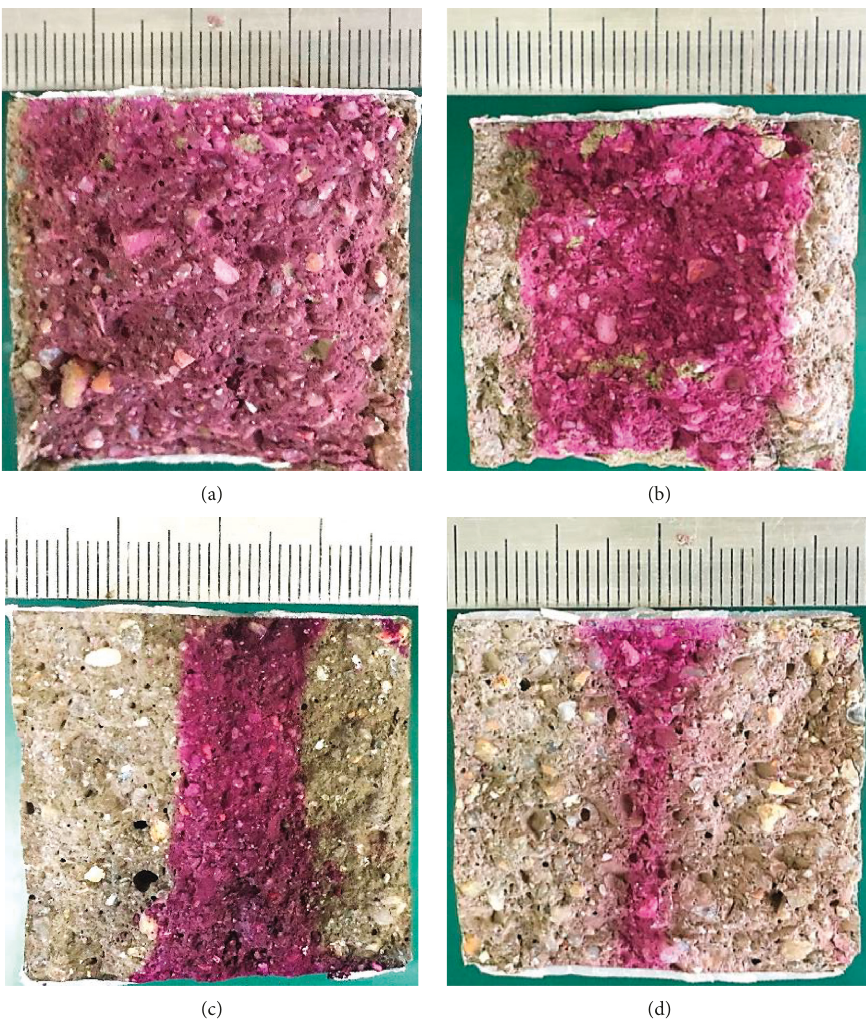
Figure 7: Carbon area of steel slag. (a) S1. (b) S4. (c) SP1. (d) SP4.